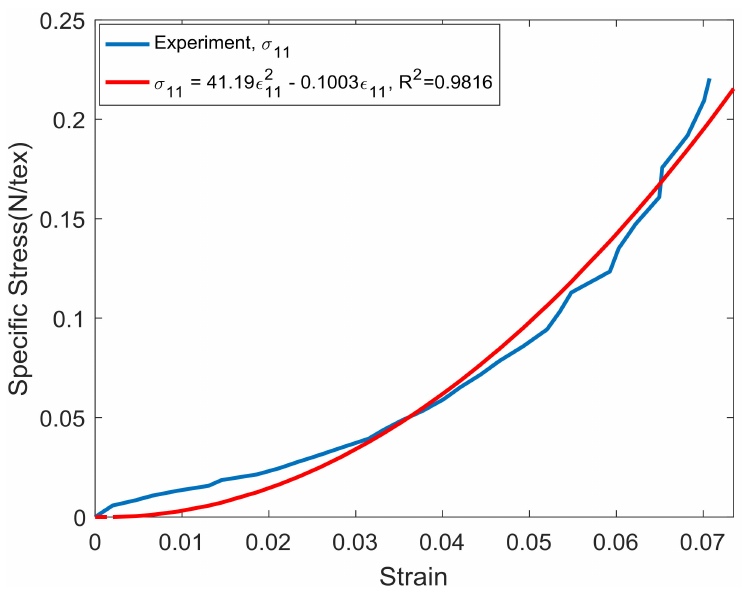
Figure 12. Specific stress vs. strain of the rope and its curve fitting in the first